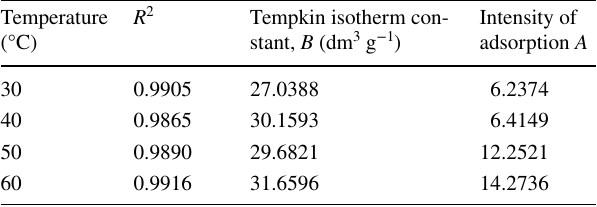
Table 5 Temkin isotherm parameters for adsorption of methylene blue on coconut coir dust with varying temperature R 2 Intensity of Temperature (°C)